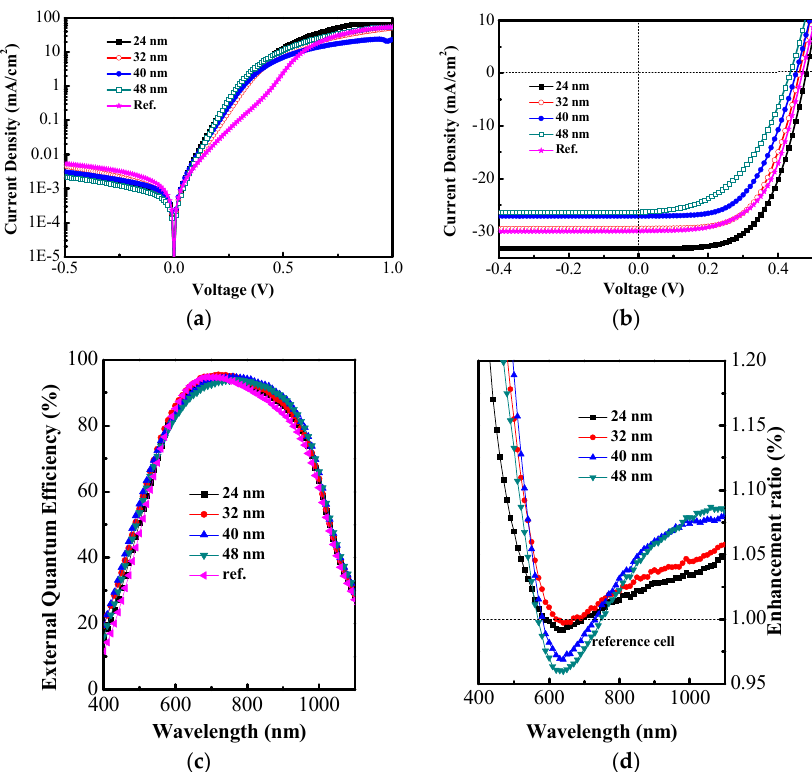
Figure 4. Photocurrent ‐ voltage characteristics for heterojunction solar cells containing TiO 2 at different thicknesses: ( a ) dark I ‐ V characteristics; ( b ) photocurrent ‐ voltage characteristics obtained under AM 1.5G; ( c ) external quantum efficiency (EQE) of solar cells; and ( d ) ratio of EQE enhancement of solar cells with TiO 2 interlayer relative to the reference cell.